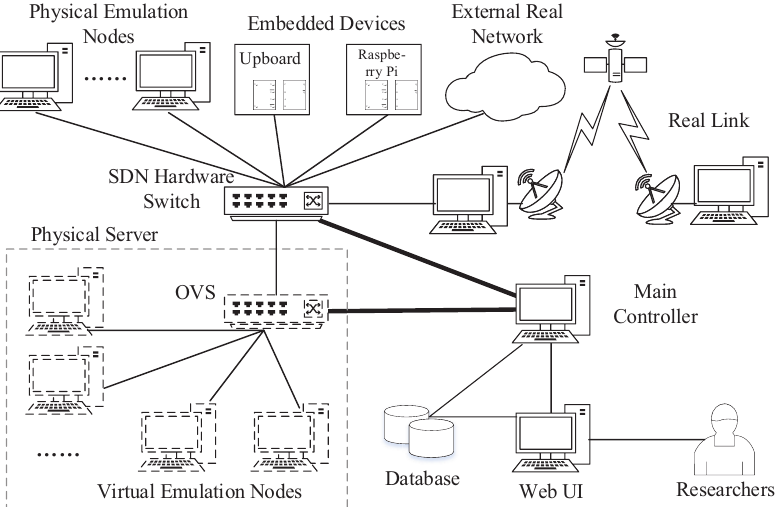
Figure 2. Physical implementation model of the proposed